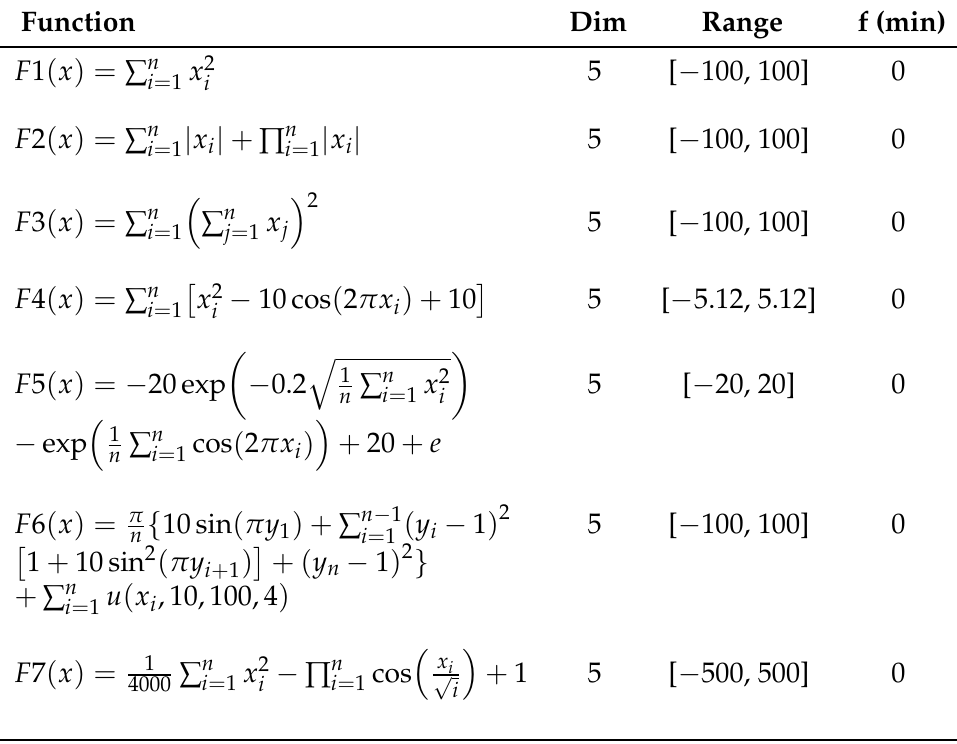
Table 1. Benchmark functions. Function